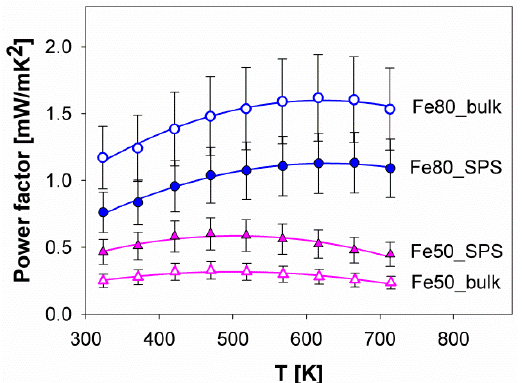
Figure 10. The trend of the power factor as a function of the temperature for samples Fe80 and Fe50. The curves fitting the experimental points are second order polynomial functions.